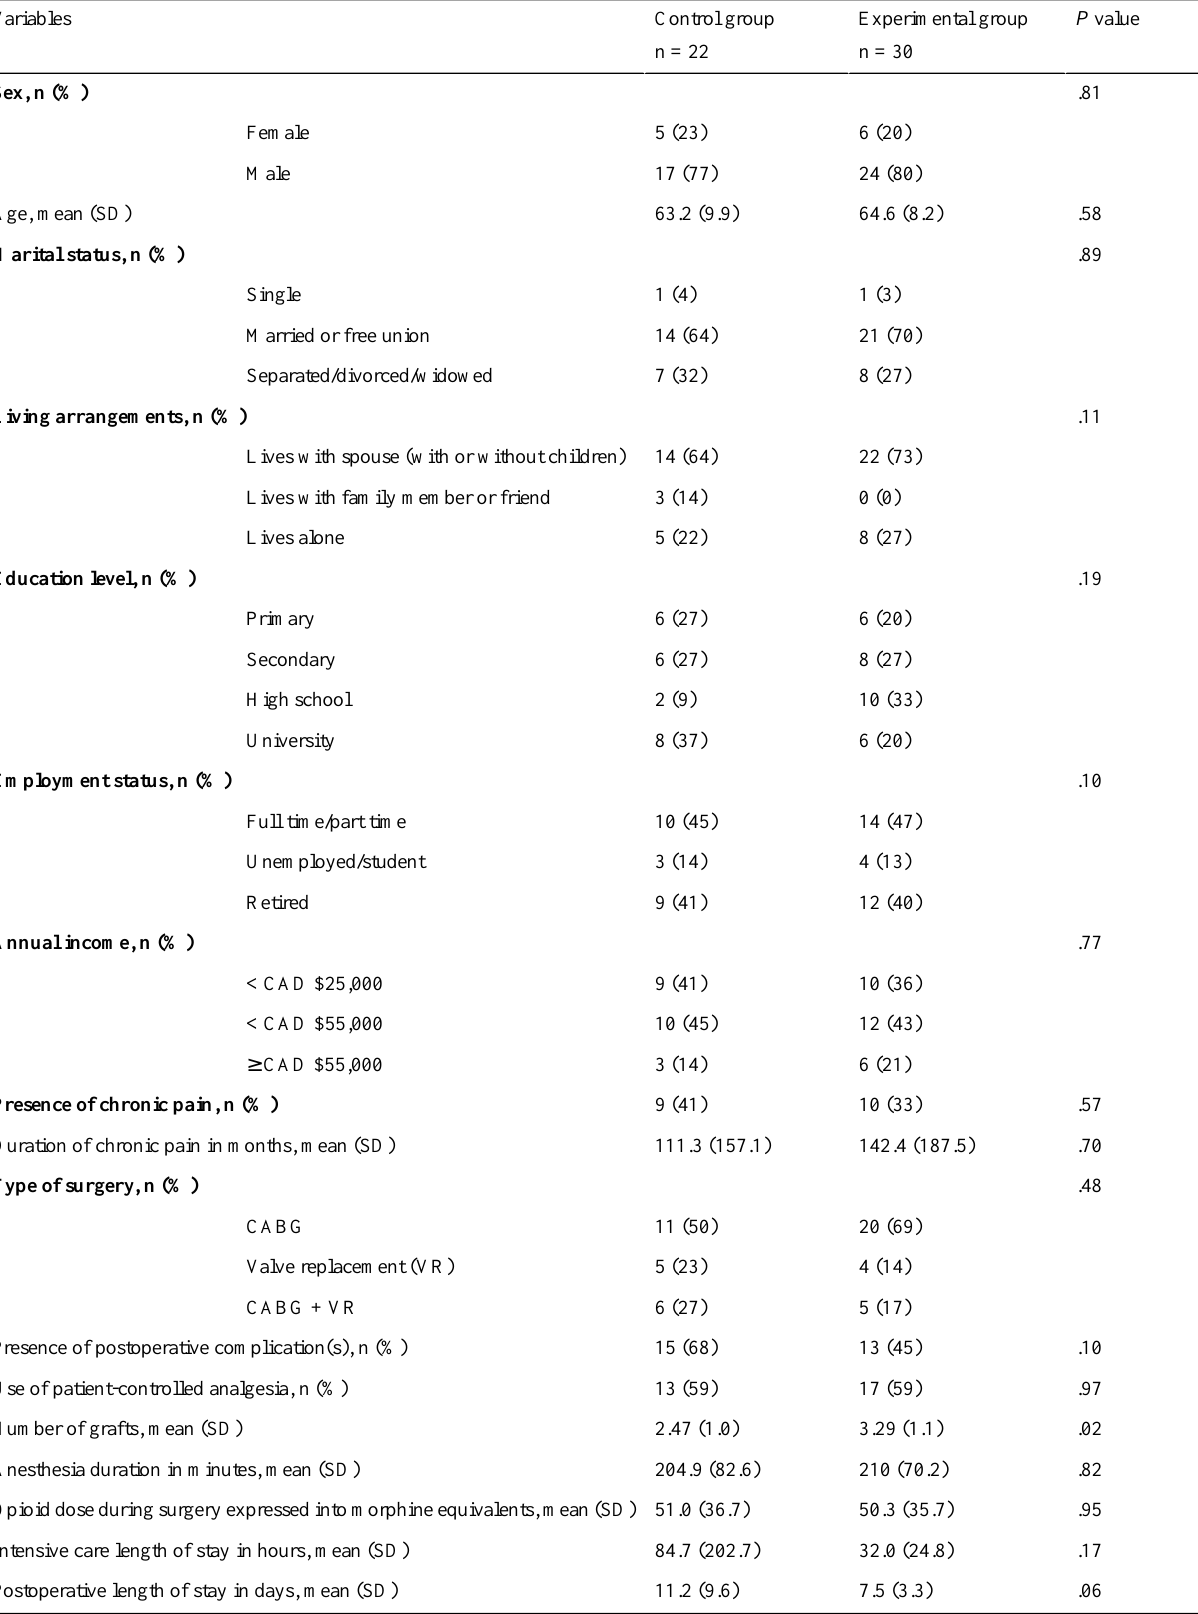
Table 3. Demographic and clinical characteristics of the participants in the control and experimental